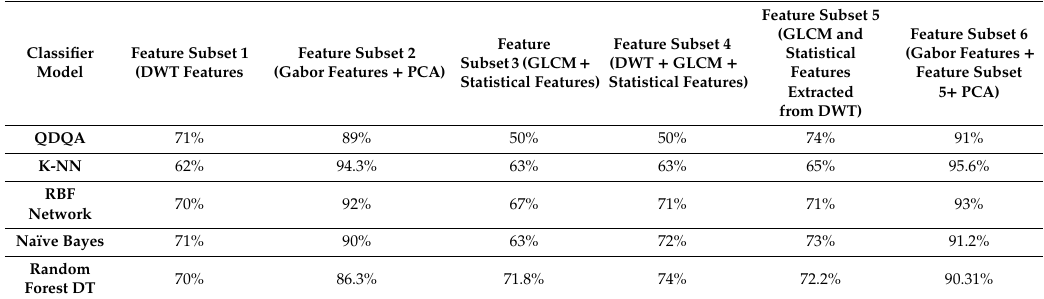
Table 2. Classification accuracy of individual classifiers constructed using di ff erent combinations of feature extraction methods.